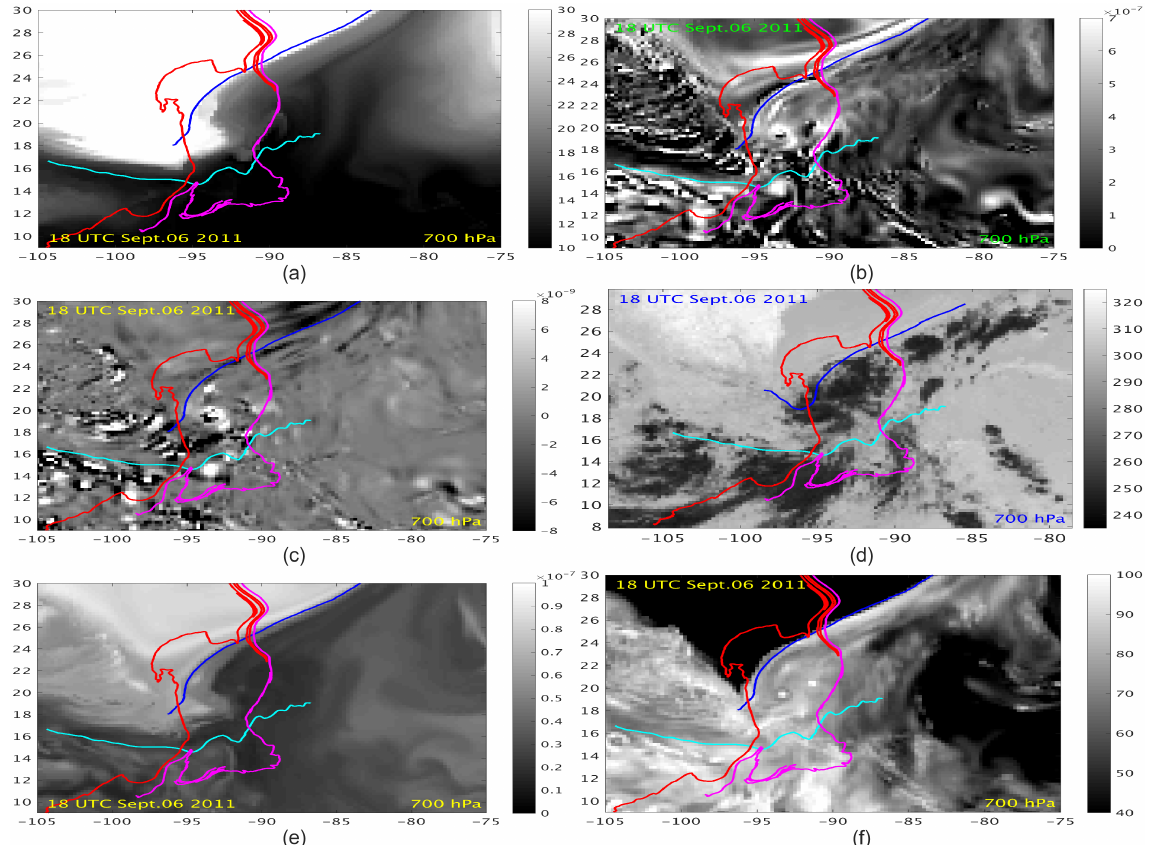
Figure 4. The stable (red, magenta) and unstable (blue, cyan) manifolds are overlaid on the latitude tracer field (degrees) (a) , the PV field (Km 2 kg − 1 s − 1 ) (b) , the OW field (s − 2 ) (c) , the GOES 3.9µm brightness temperature (K) (d) , the ozone mixing ratio (gkg − 1 ) (e) , and the relative humidity field (f) at 18:00UTC on 6 September at